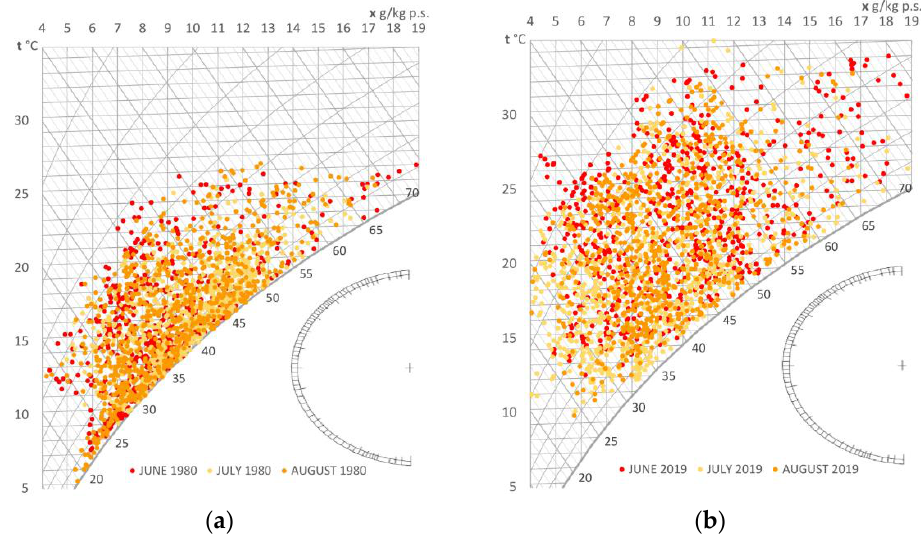
Figure 2. Hourly average external air parameters for Warsaw for the summer months (June, July, August) in the i-x Mollier diagram for years: ( a ) 1980 and ( b ) 2019.